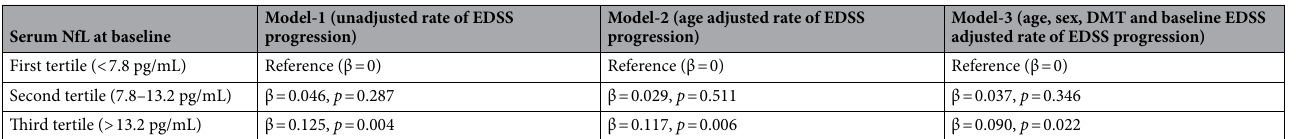
Table 2. Multivariate regression model of serum NfL tertile and rate of EDSS progression (points per year).